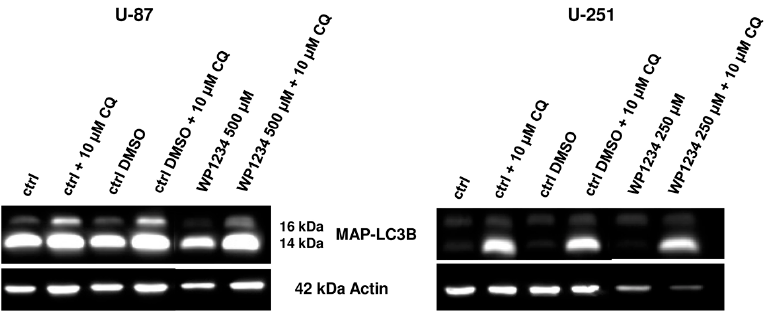
Figure 11. Representative Western blot analysis showing the expression of autophagy marker— MAP-LC3 protein in response to IC 50 concentration treatment with WP1234 (500 μ M for U-87 and 250 μ M for U-251 cells) (72 h) alone or in combination with CQ (10 uM). Actin was used as a loading control.